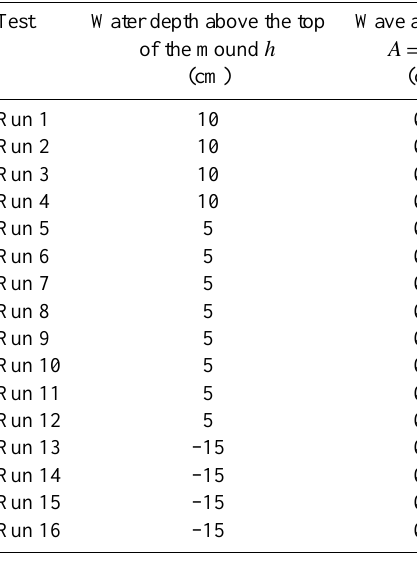
Table 1. Experimental wave characteristics.